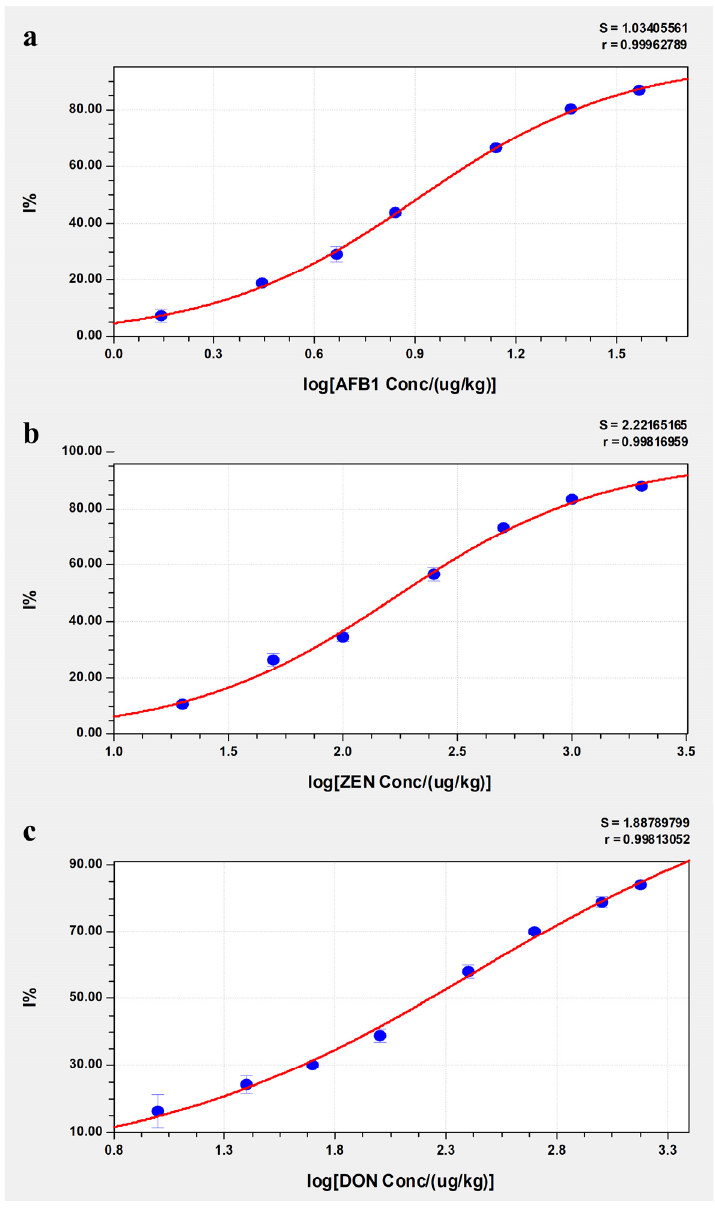
Figure 3. Standard curves for AFB1, ZEN and DON in corn. ( a ) AFB1; ( b ) ZEN; ( c ) DON.